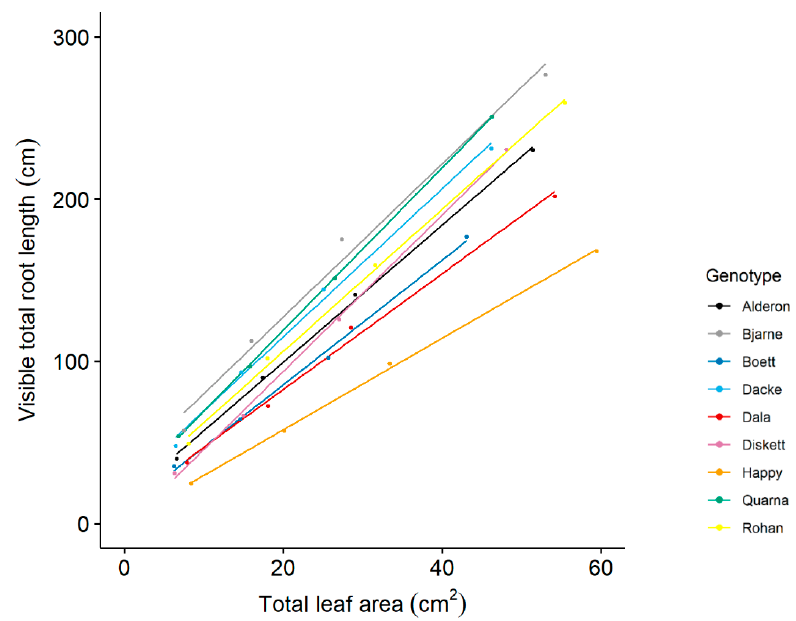
Figure 3. Allocation between leaf and root for nine spring wheat genotypes grown under controlled conditions in a phenotyping facility. The four values for each genotype represent the means of eight replicates from days 7, 11, 14 and 18, respectively. Linear regressions: ‘Alderon’, r 2 = 0.998, p < 0.001; ‘Bjarne’, r 2 = 0.980, p = 0.007; ‘Boett’, r 2 = 0.995, p = 0.002; ‘Dacke’, r 2 = 0.993, p = 0.002; ‘Dala’, r 2 = 0.992, p = 0.003; ‘Diskett’, r 2 = 0.998, p < 0.001; ‘Happy’, r 2 = 0.999, p < 0.001; ‘Quarna’, r 2 = 0.999, p < 0.001; ‘Rohan’, r 2 = 0.997, p =